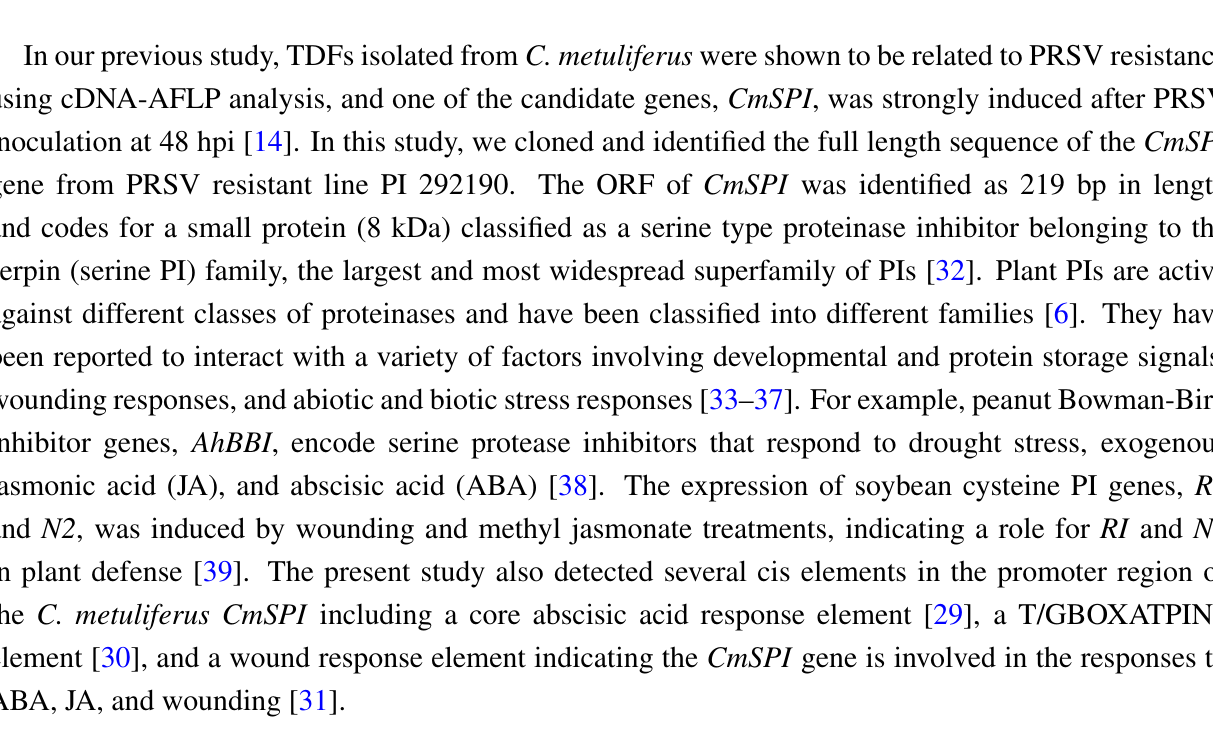
Table 3. Infectivity assays of T